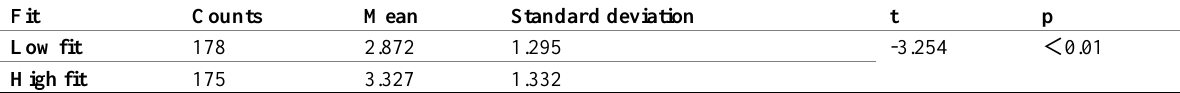
Table 8: Results of manipulation